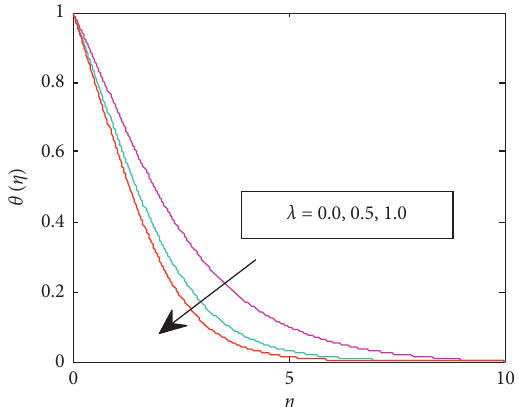
Figure 16: Temperature distribution for different values of mixed convection